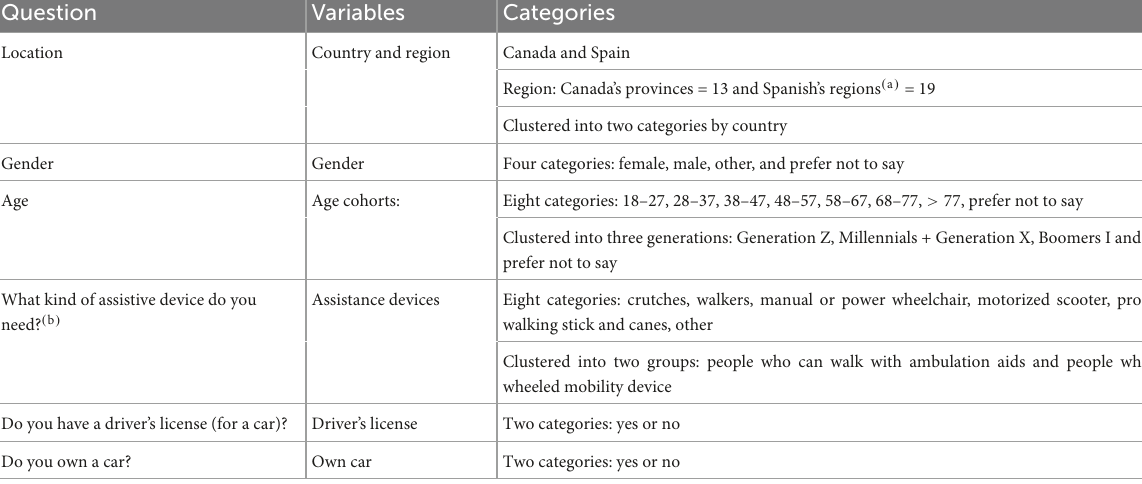
TABLE 1 Questionnaire’s question, variables, and categories in section 1.